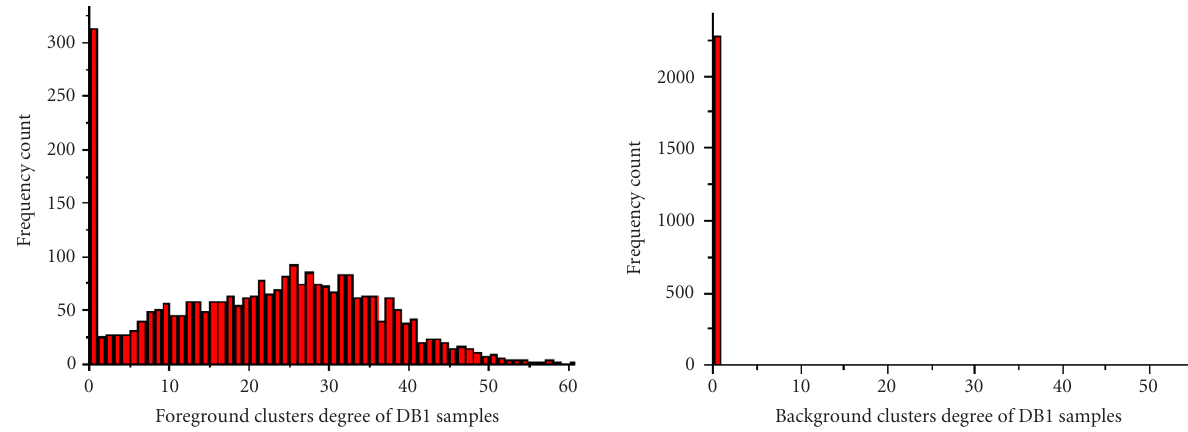
Figure 6: The block clusters degree CluD of the samples. The horizontal coordinate represents the value of the block clusters degree while the vertical coordinate represents the frequency count of the value.